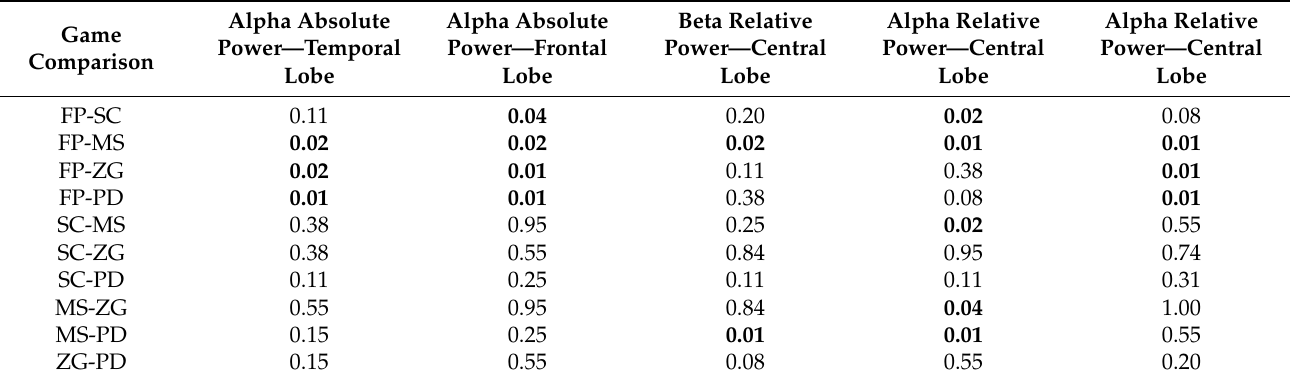
Table 12. Wilcoxon test results for statistically significant data from the Friedman test. Comparison between the games (Finger Painting (FP), Sorting Cubes (SC), More Switches (MS), Zero Gravity Switches (ZG), and Punch the Dummy